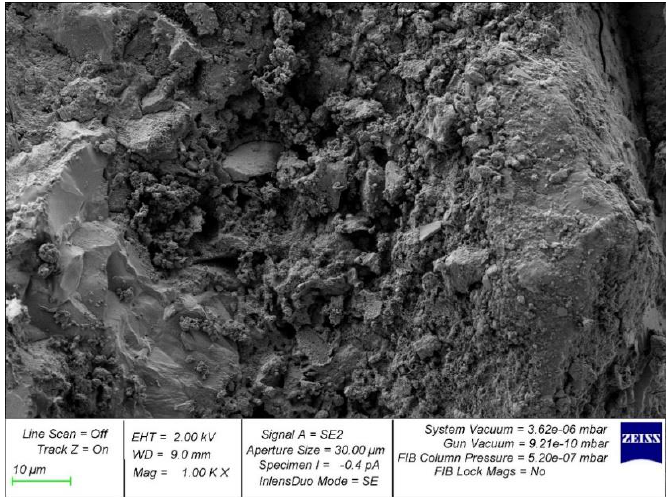
Figure 12. Sample with partial replacement of cement with eggshell powder at 20%.